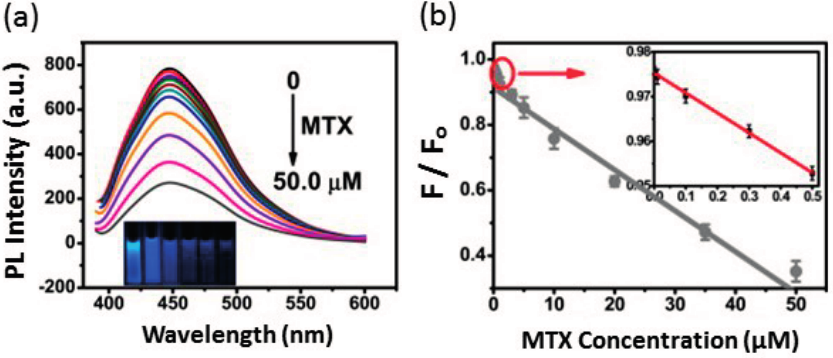
Figure 1. ( a ) The fluorescence spectra of NS-co-doped fluorescent carbon nanodots (NSCDs) as treated with different concentrations of methotrexate (MTX) ranging from 0–50.0 µM; the intensity decreases as the concentration of MTX increases and FRET is inhibited. The inset shows photographs that correspond to the increasing concentrations of MTX; ( b ) The linear relationship between fluorescence and MTX